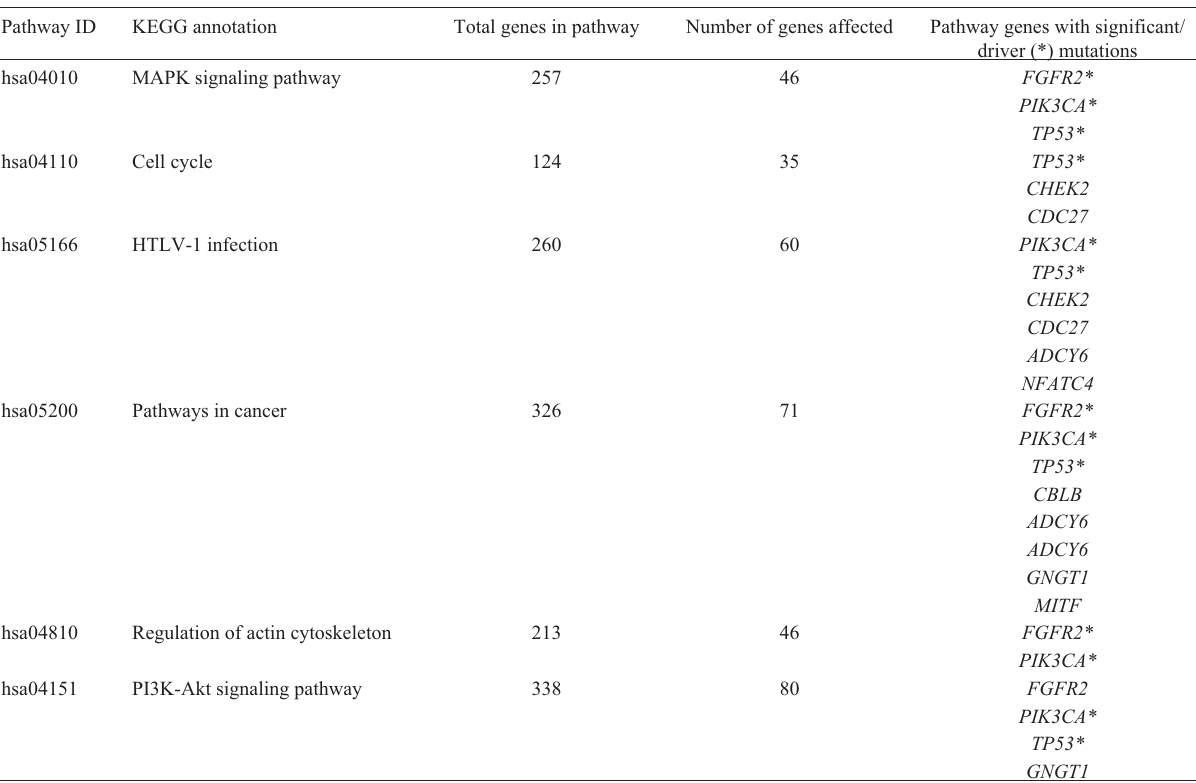
Table 5 - Significantly involved pathways ( p (cid:3) 0.05) identified by IntOGen-Mutations platform . Driver mutations in each pathway are in bold text and marked with an asterisk (*). Pathway ID KEGG annotation Total genes in pathway Number of genes affected Pathway genes with significant/